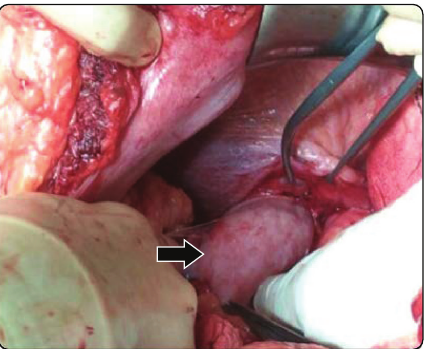
Figure 3: Gastric herniation (photo taken from the left of the patient; arrow points at stomach being pulled back into the abdomen).